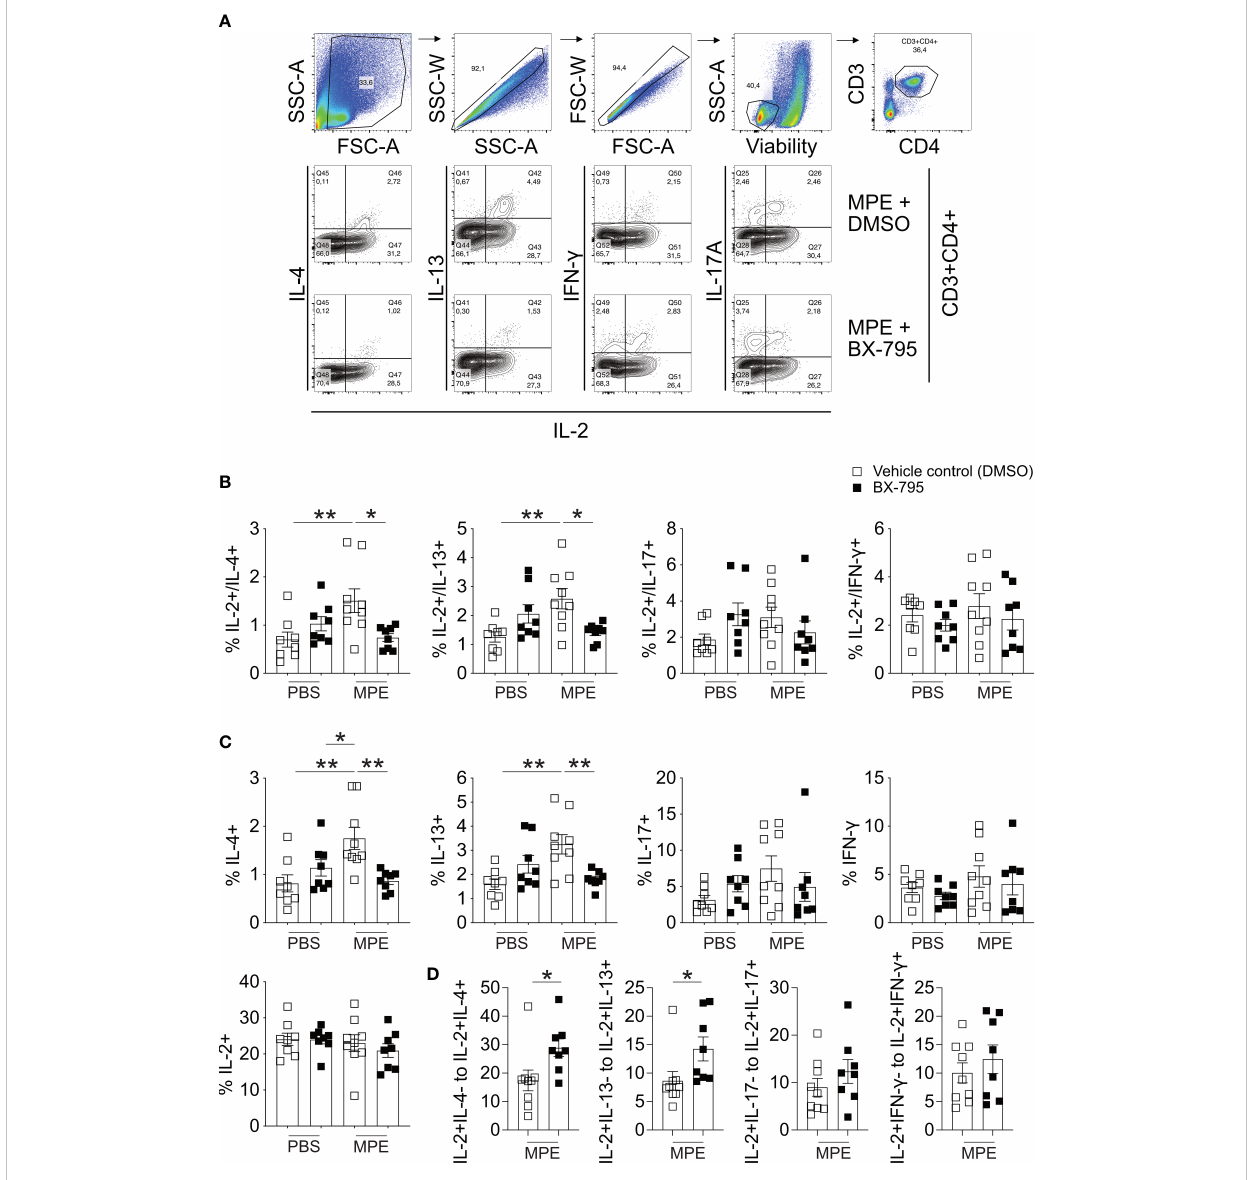
FIGURE 7 BX-795 reduces MPE induced IL-2/IL-4 and IL-2/IL-13 co-producing T cells but not overall IL-2 producers in a murine model of mugwort allergy. Lung cells derived from mice challenged as shown in Figure 6A were stimulated for 4 h in the presence of PMA/ionomycin and protein transport inhibitors monensin/brefeldin A and then stained for CD3, CD4 and the indicated cytokines. (A) , shown is the gating strategy for the analysis of IL-2/ cytokine double positive cells and representative FACS plots showing co-production of indicated cytokines with IL-2 for mice treated with MPE plus solvent and MPE plus BX-795. (B) , shown are the percentages of cells co-producing IL-2 and the indicated second cytokine as percent of CD3 + CD4 + T cells for each treatment group. (C) , shown are the percentages of all cells of CD3 + CD4 + T cells producing the indicated cytokine. The total percentage of the respective cytokine producing cells was calculated from the IL-2/cytokine gates shown in (A) . The percentage of all IL-2 producing cells of CD3 + CD4 + T cells was calculated from the IL-2/IL-4 plots. (D) , shown are the ratios of IL-2 + /Cytokine - cells relative to IL-2 + / Cytokine + cells for MPE plus solvent and MPE plus BX-795 treated mice. Cells stained for the indicated cytokines were stimulated for 4 h in the presence of PMA/ionomycin and protein transport inhibitors monensin/brefeldin A, Data show the mean ± SEM of pooled results from two independently performed experiments containing n = 8 both PBS groups, MPE plus BX-795 and n = 9 MPE plus DMSO (B-D) . The indicated p-values were calculated using one-way ANOVA followed by Dunnett ’ s test (B, C) or by an unpaired two-sided Student ’ s t-test (D) . All comparisons performed against MPE plus solvent treated. Only statistically signi fi cant changes are indicated with *, p < 0.05; **, p <